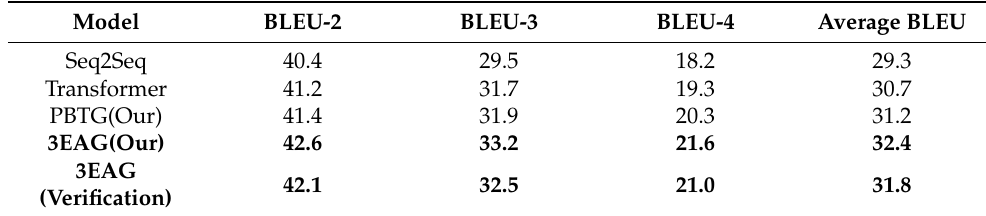
Table 6. BLUE’s evaluation results of fixed topics.